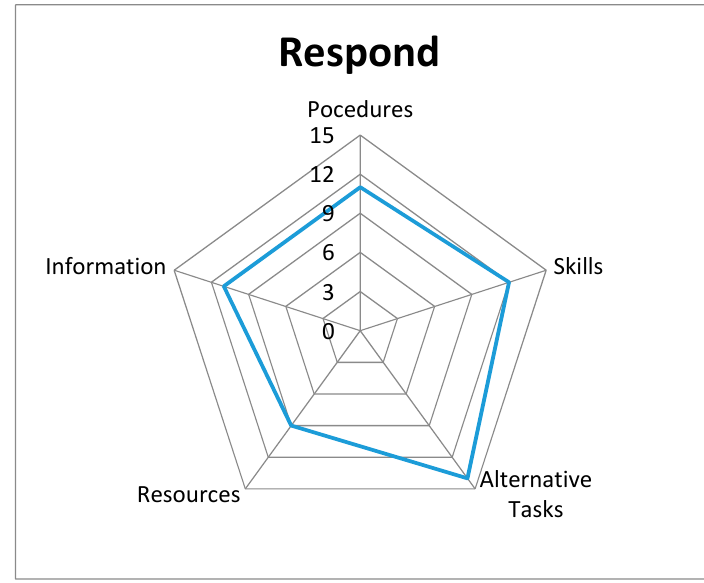
Figure 2. Potential to respond—Yes responses.